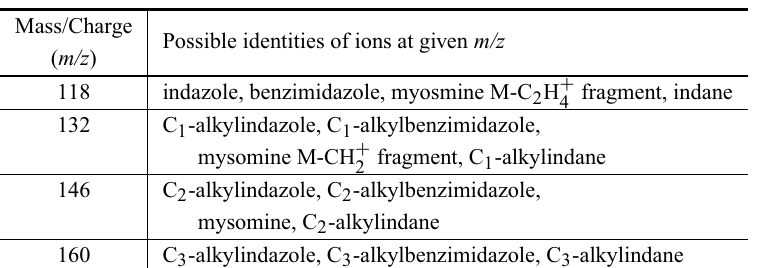
Cigarette specif